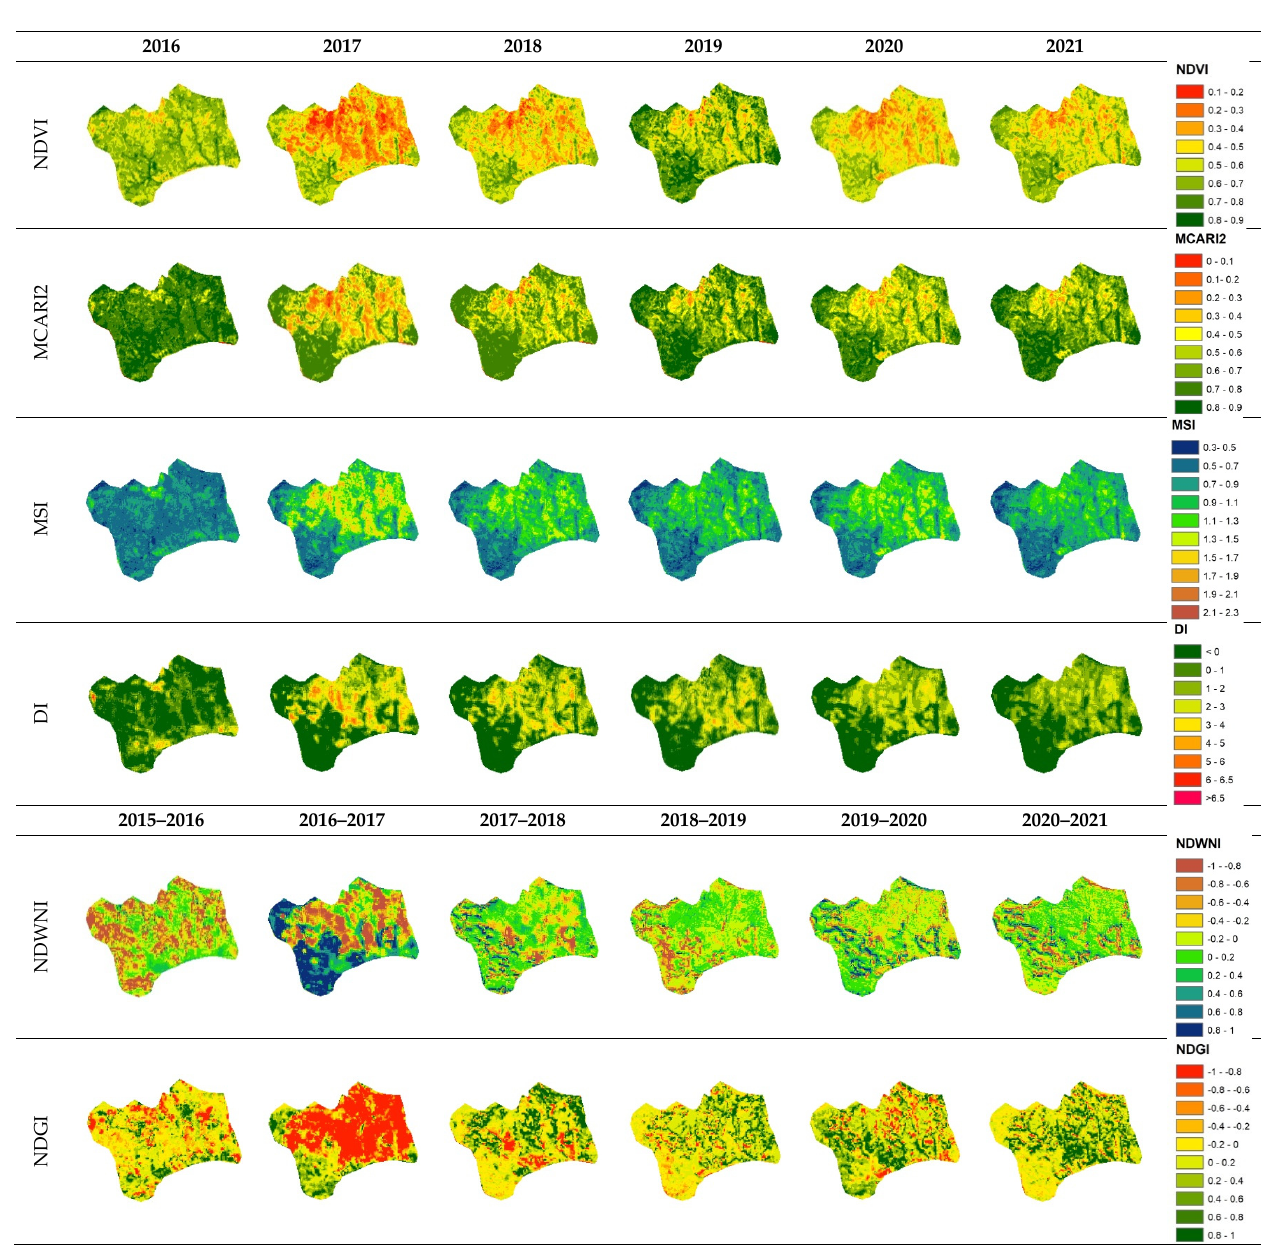
Figure 3. Dynamics of the spectral indices calculated for the period of 2016 – 2021 . Surprisingly, the areas with no disturbance or negative DI values prevailed during the entire studied period (Figure 3, Table A2). However, this maximum was highest in the year before the fire event. Moreover, during the same year, the highest territorial spread of the areas with great disturbance was observed. Areas from the same category (DI>5) were also recorded in the following 2017 and 2018 years (Figure 3, Table A2). After 2019, with increasing temporal distance from the fire event, areas falling into this category were not observed. In the year before the fire event, a large portion of the areas